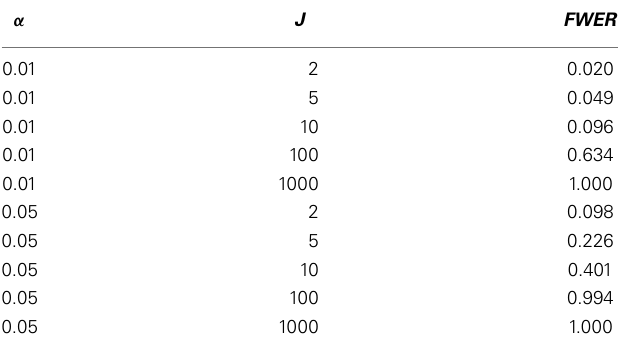
Table 1 | FWER versus number of tests and the size of individual